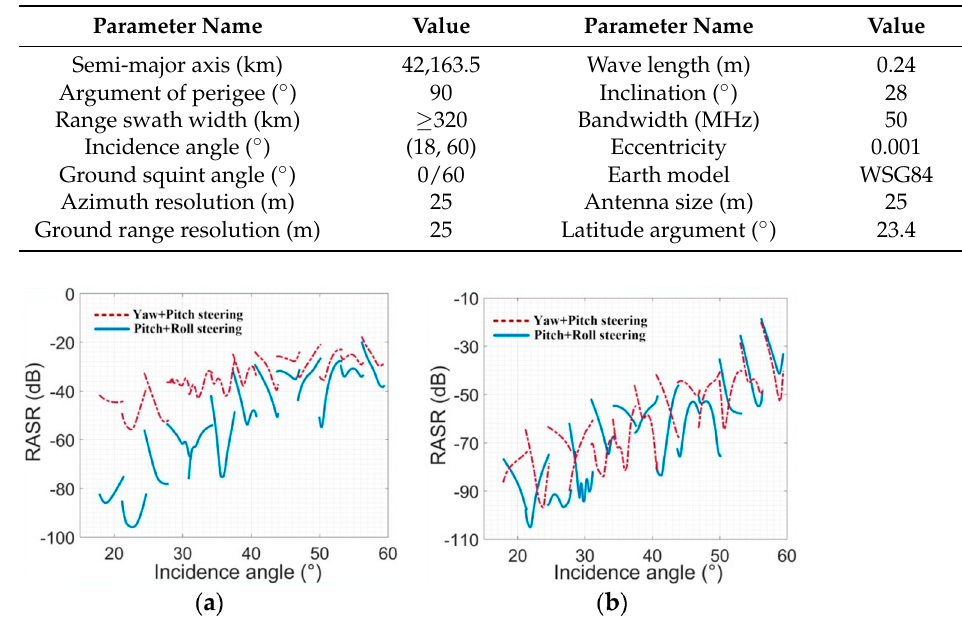
Figure 13. RASR of Geo-SAR at a latitude argument of 23.4 ◦ . ( a ) Broadside. ( b ) 60 ◦